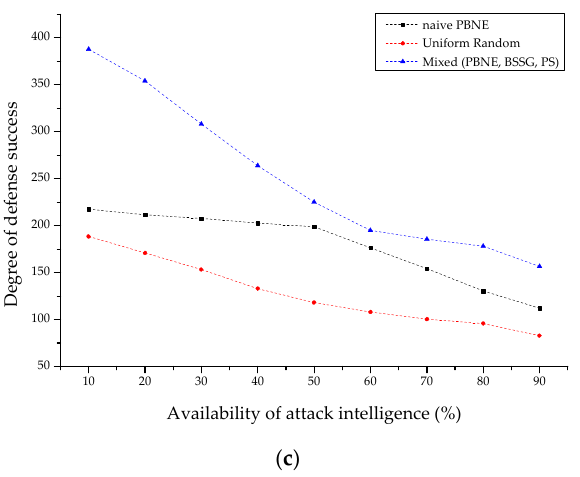
Figure 11 . Comparison of the defense effectiveness each decision scheme in Scenario2. ( a ) Availability attack. ( b ) Integrity attack. ( c ) Validity of intelligence.